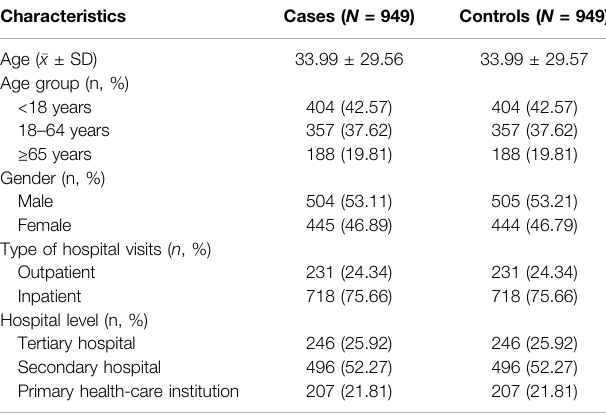
TABLE 2 | Baseline characteristics of patients with suspected allergic reactions and matched controls. Characteristics